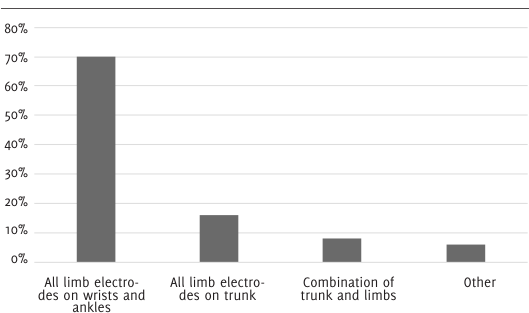
Figure 1. Frequency of incorrect limb electrode placement. 9